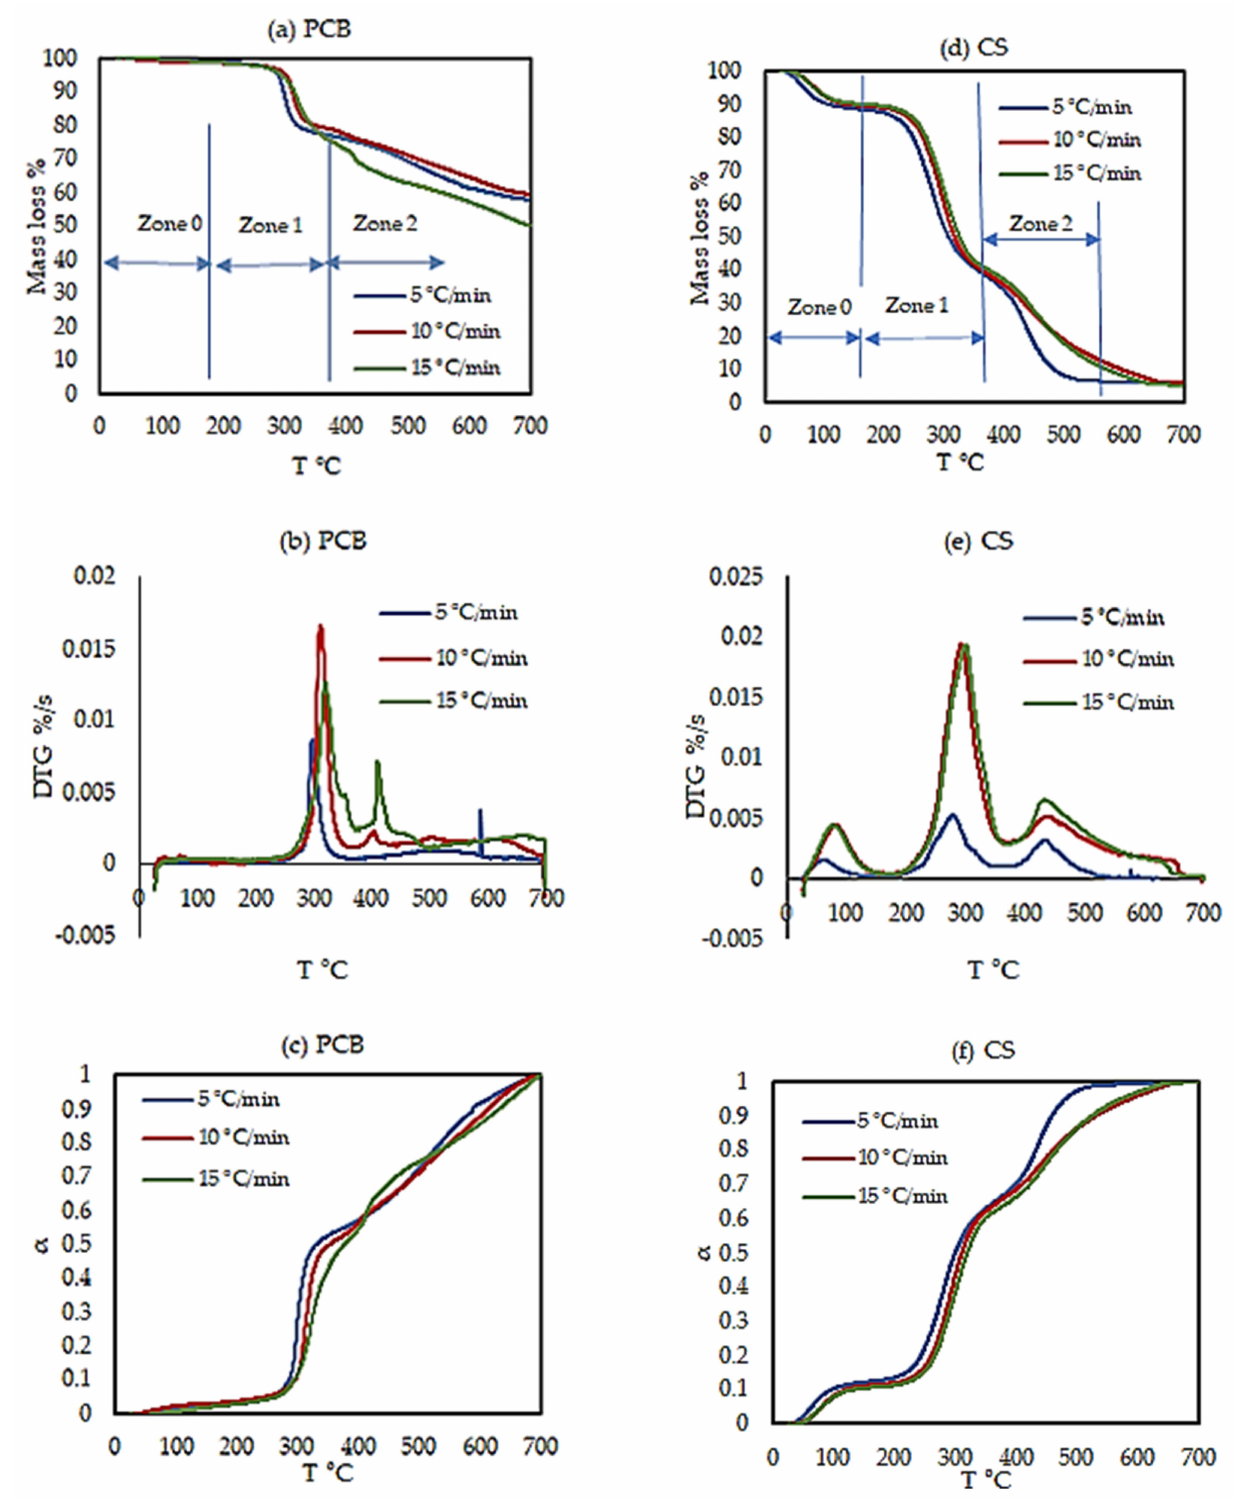
Figure 1. TG-DTG and variation of conversion as a function of temperature plots for the pyrolysis of WPCBs ( a – c ) and CS ( d – f